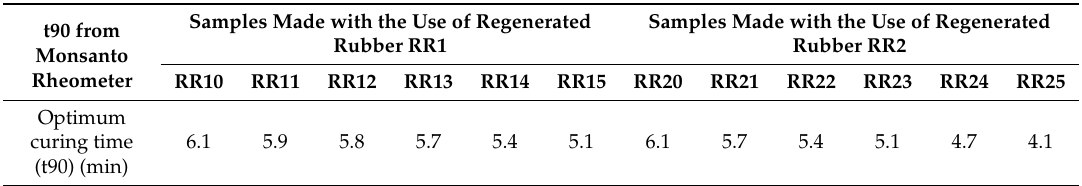
Table 6. Optimum curing time (t90) of the mixes as evaluated by a Monsanto Rheometer. t90 from